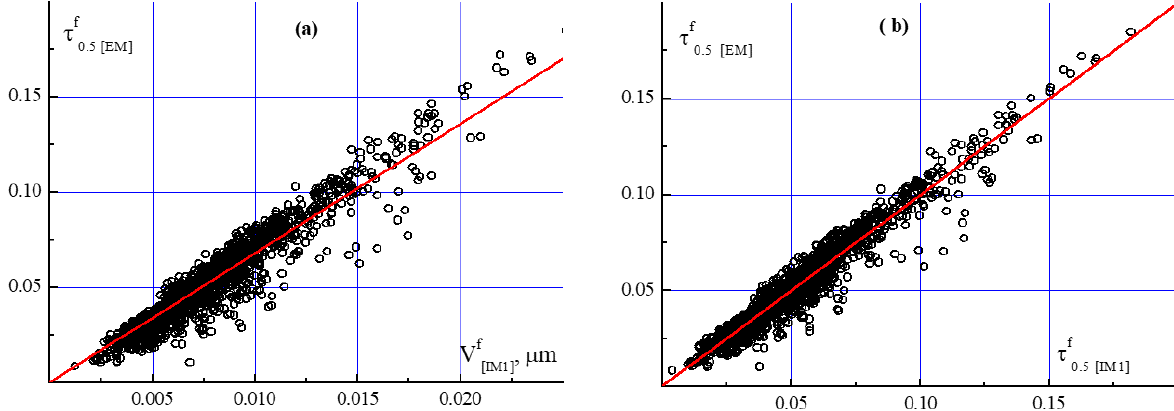
Figure 4. (a) The interrelation between τ f respective inversion (IM1) and empirical (EM)